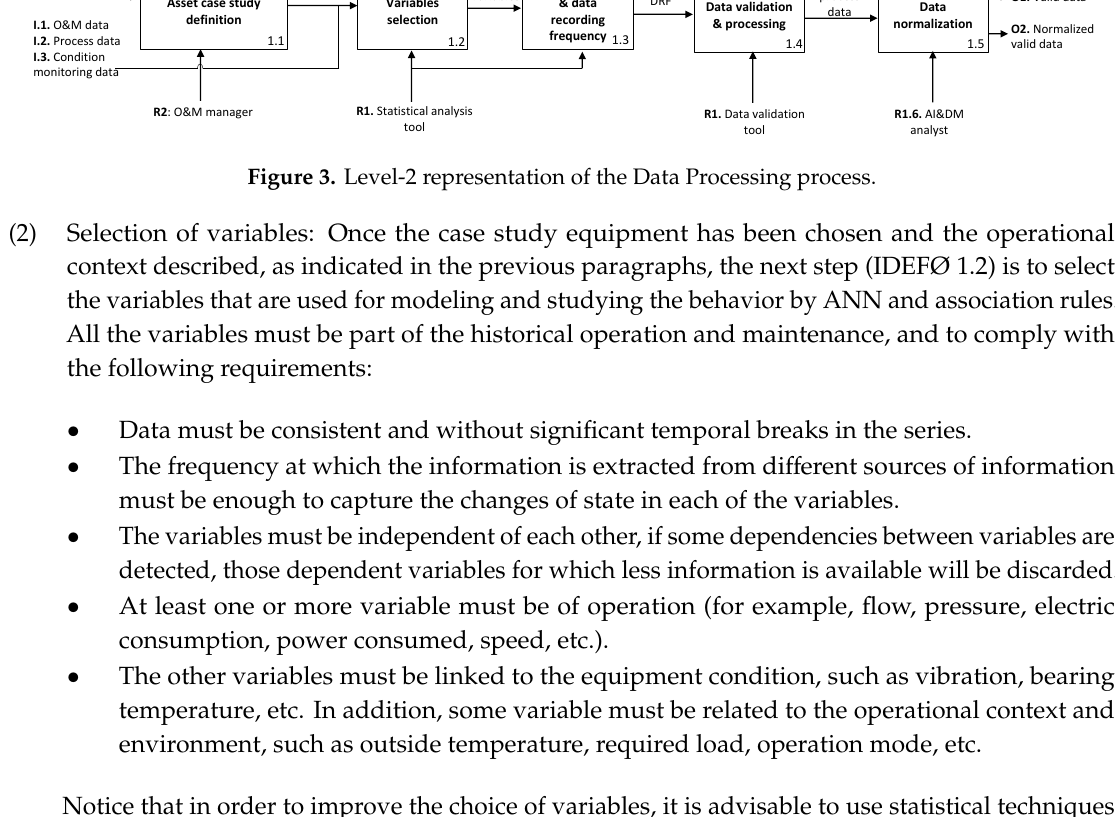
Figure 3 Level-2 representation of the Data Processing process